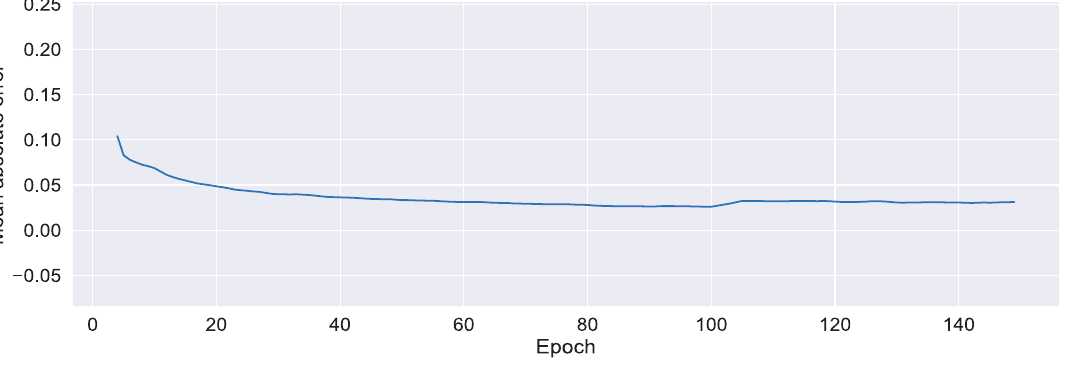
Figure 16 . Mean absolute error for the surrogate model calculated as the absolute difference between the estimated optimization score and true optimization value. The shaded part presents one standard deviation in each direction.